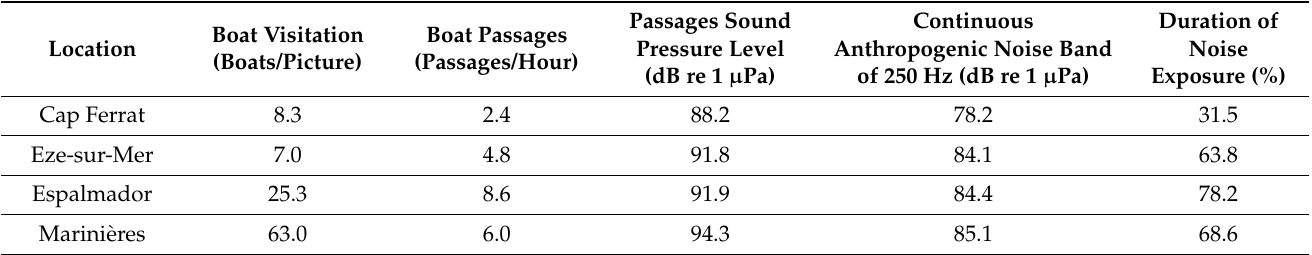
Table 1. Mean values of the five MNP-related variables measured at the four study